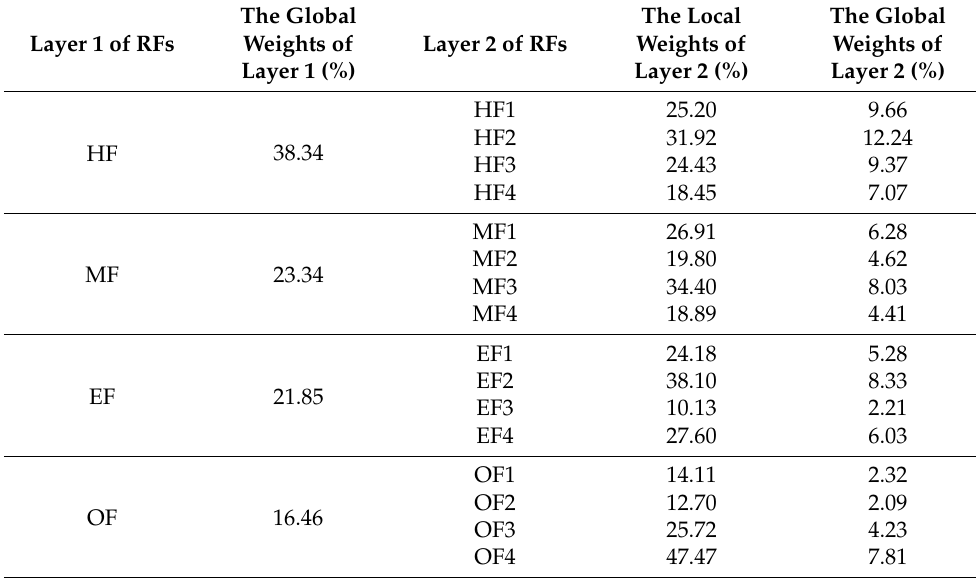
Table 4. The likelihood weights of RFs.